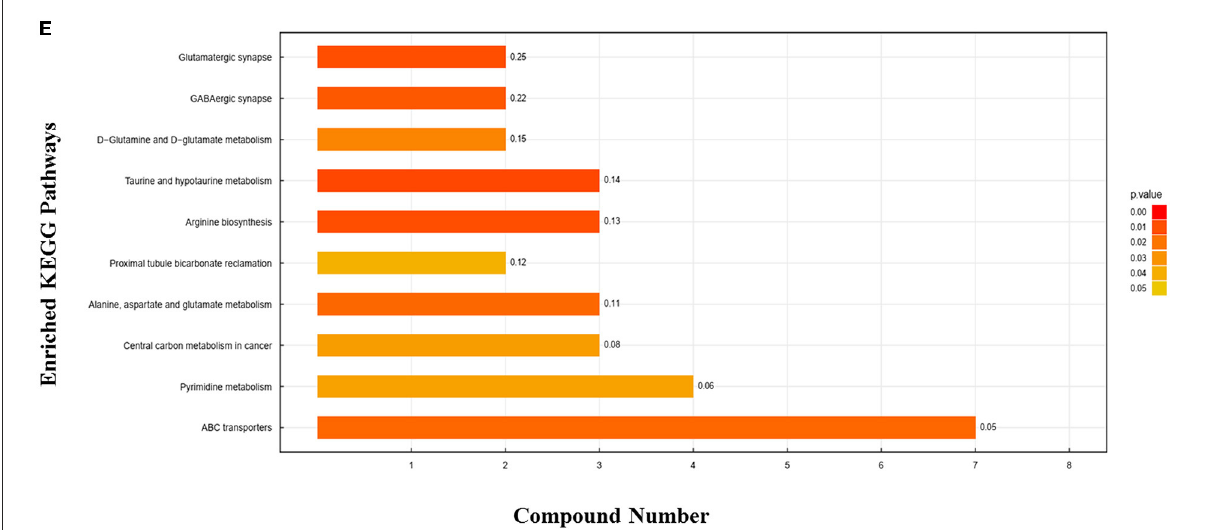
FIGURE1 Bioinformatics analysis of differential metabolites. (A) Significant difference metabolite hierarchical clustering results in positive ion mode. (B) Significant difference metabolite hierarchical clustering results in negative ion mode. (C) Relevance among significant difference